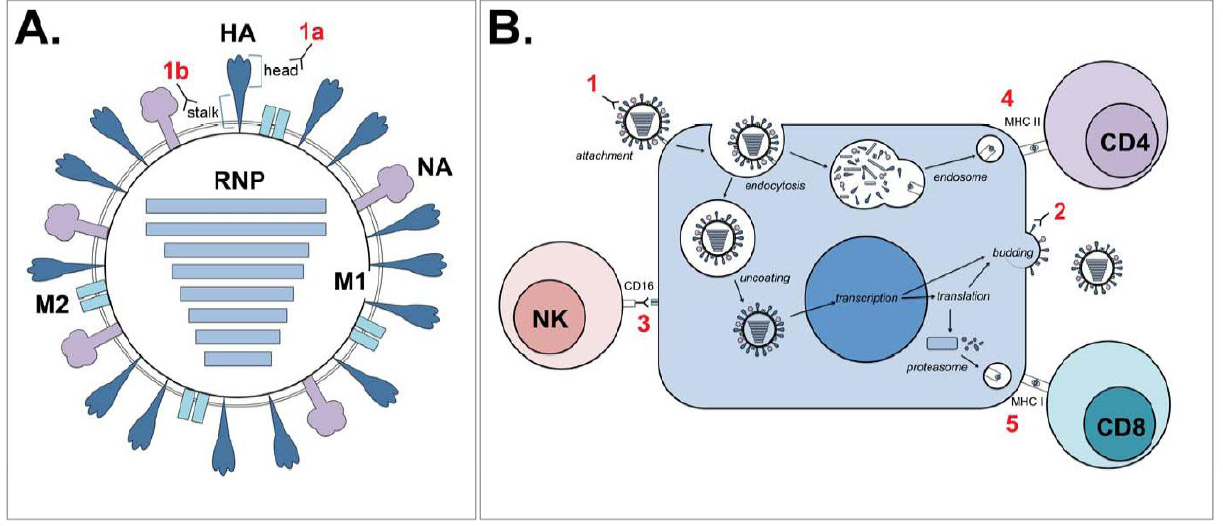
Figure 1. Schematic representation of possible immunological correlates of protection. Numerals in red show various immunological correlates of protection as indicated below. ( A ) Cartoon of an influenza virion, showing the hemagglutinin (HA) surface glycoprotein (stem and head), the neuraminidase (NA) surface glycoprotein, the matrix 2 (M2) ion channel, the matrix 1 (M1) structural protein and the ribonucleoproteins (RNPs: the combination of genomic RNA, viral polymerases PA, PB1 and PB2 and nucleoproteins (NP)). Antibodies directed against HA can either target the globular head (1A) or stem region (1B). ( B ) Interference of production of progeny virus by infected cells by various immunological correlates of protection, including (1) antibodies against HA head, interfering with binding or HA stem, potentially interfering with post-entry functions of HA, like endosomal membrane fusion; (2) antibodies against NA, limiting the production of progeny virus; (3) antibodies against M2e, HA or NA, followed by ADCC through CD16 signaling in NK cells (or phagocytosis, not shown); (4) virus-specific CD4 + T lymphocytes; and (5) virus-specific CD8 + T lymphocytes that possess cytolytic